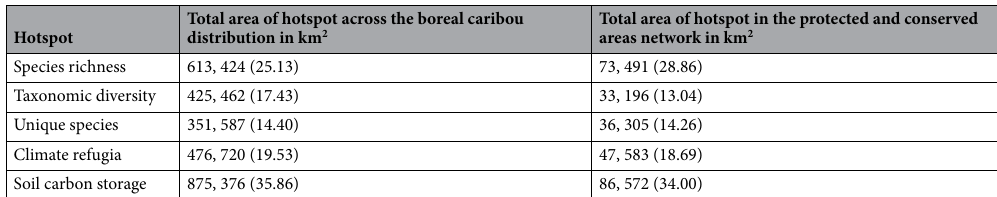
Table 1. Total area (km 2 ) and area within the protected and conserved areas network for each hotspot across the boreal caribou distribution in Canada. Values in brackets represent percentages across the boreal caribou distribution and protected and conserved areas network,